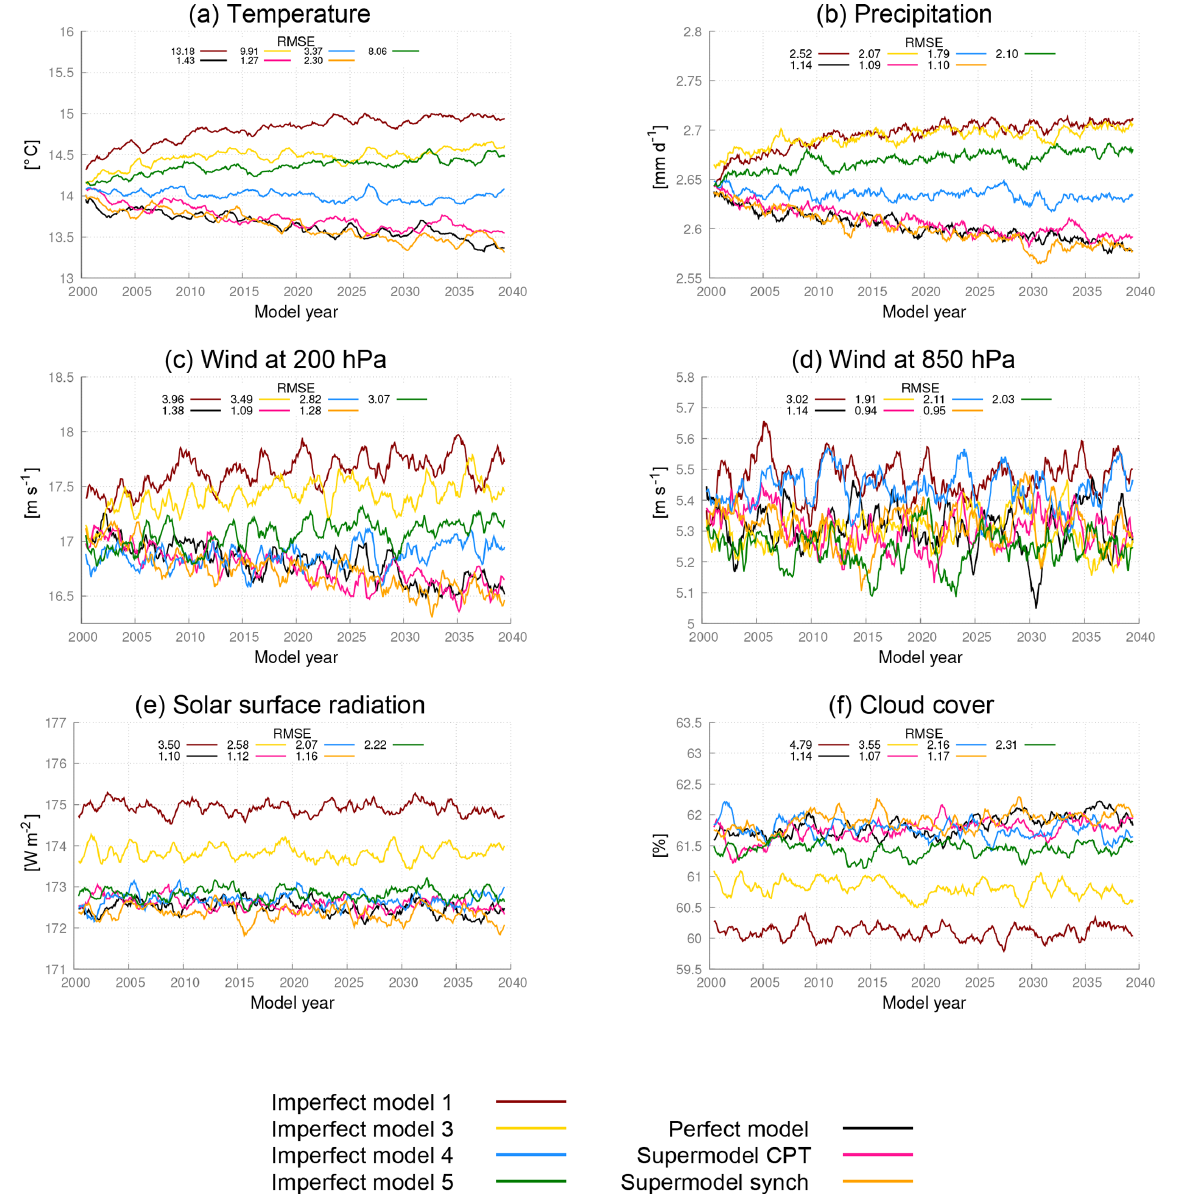
Figure 12. Global mean time series for the truth, the perfect model, the imperfect models and the two supermodels trained by CPT and the synch rule. Included is the RMSE of the model years 2011–2040 with respect to the truth. The normalized RMSE in the climatology of model years 2011–2040 with respect to the climatology of the truth is given in each panel. The normalization is such that the expected value of the perfect model error is